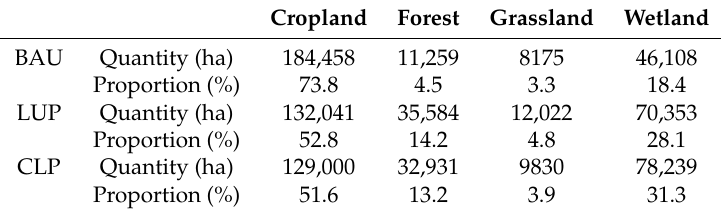
Table 6. Loss in land use types in each scenario during the whole simulation progresses. Cropland Forest Grassland